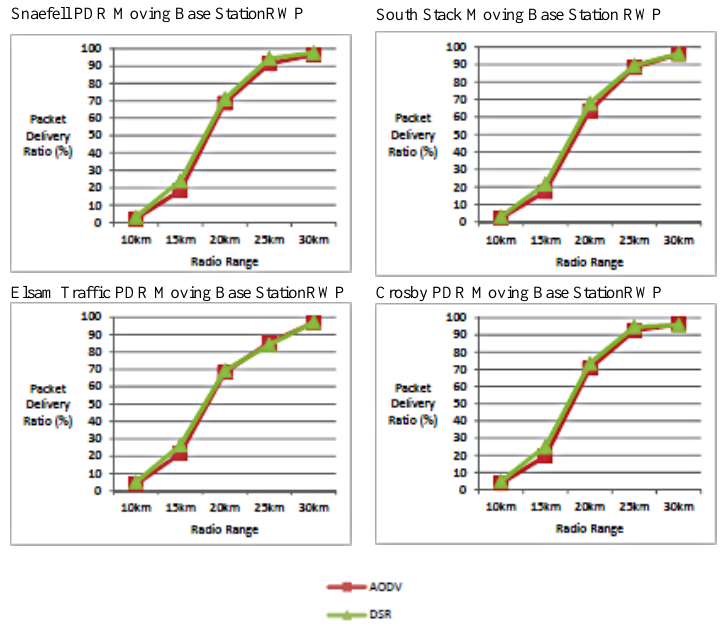
Figure 13. Moving Base Station Random Waypoint Model Packet Delivery Ratios.